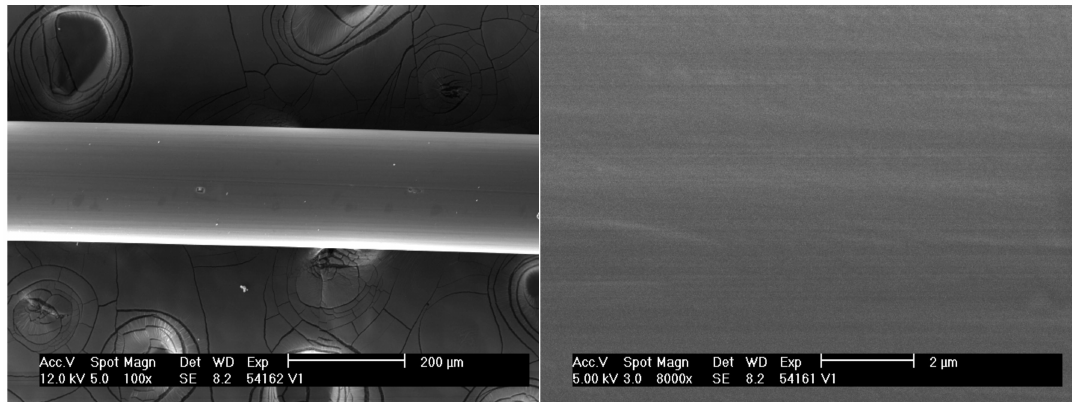
Figure 2. Thepolypropylenehollowfibers, macroscopicphotowithnodefects(onthe( left ))andthesurface quality with × 8000 magnification ( right